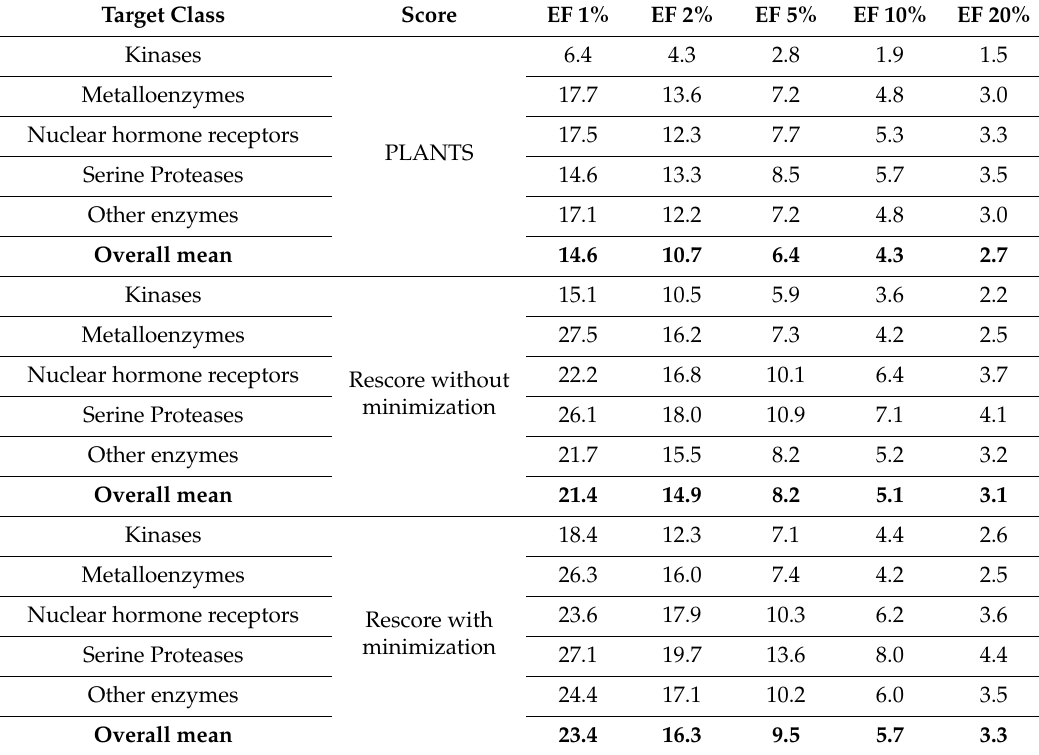
Table 1. Enrichment factor averages for the one-variable equations as generated by the EFO